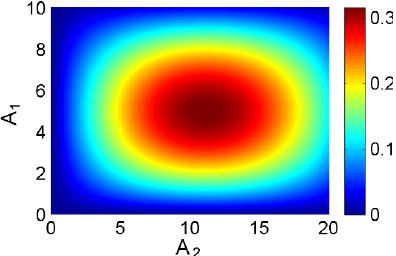
FIG. 3. The bunching factor vs laser energy modulation